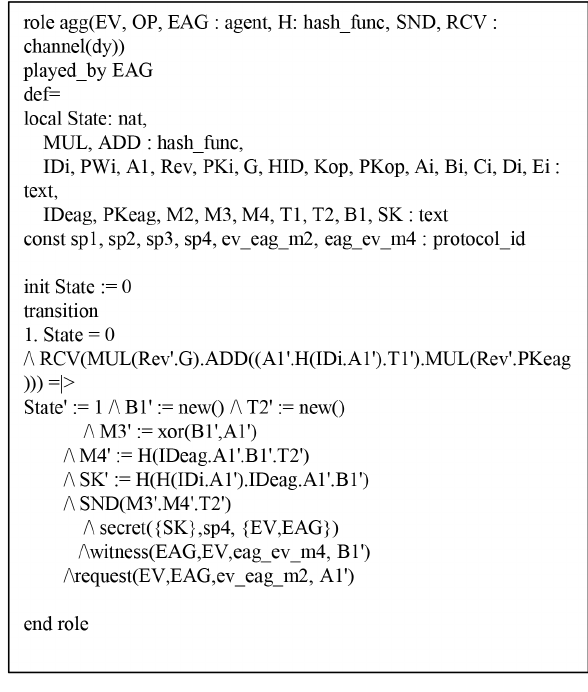
Figure 10. Specification of the energy aggregator.